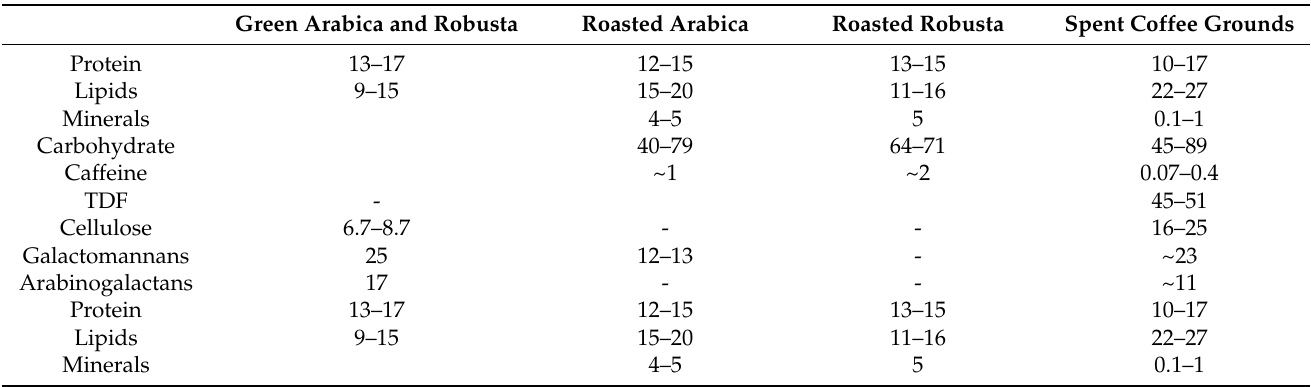
Table 2. Comparative overview of the chemical composition of spent coffee grounds in comparison to green and roasted coffee (g/100 g dry